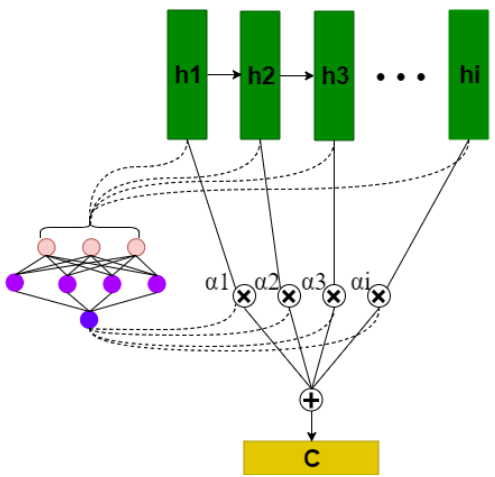
Figure 2. The structure of the “feed-forward” attention mechanism [13,19]. Vectors in the state sequence ℎ 𝑖 are fed into the learnable function φ(ℎ 𝑖 ) to produce a weight vector α . The vector c is computed as a weighted average of ℎ 𝑖 with the weighting given by the weight vector α .